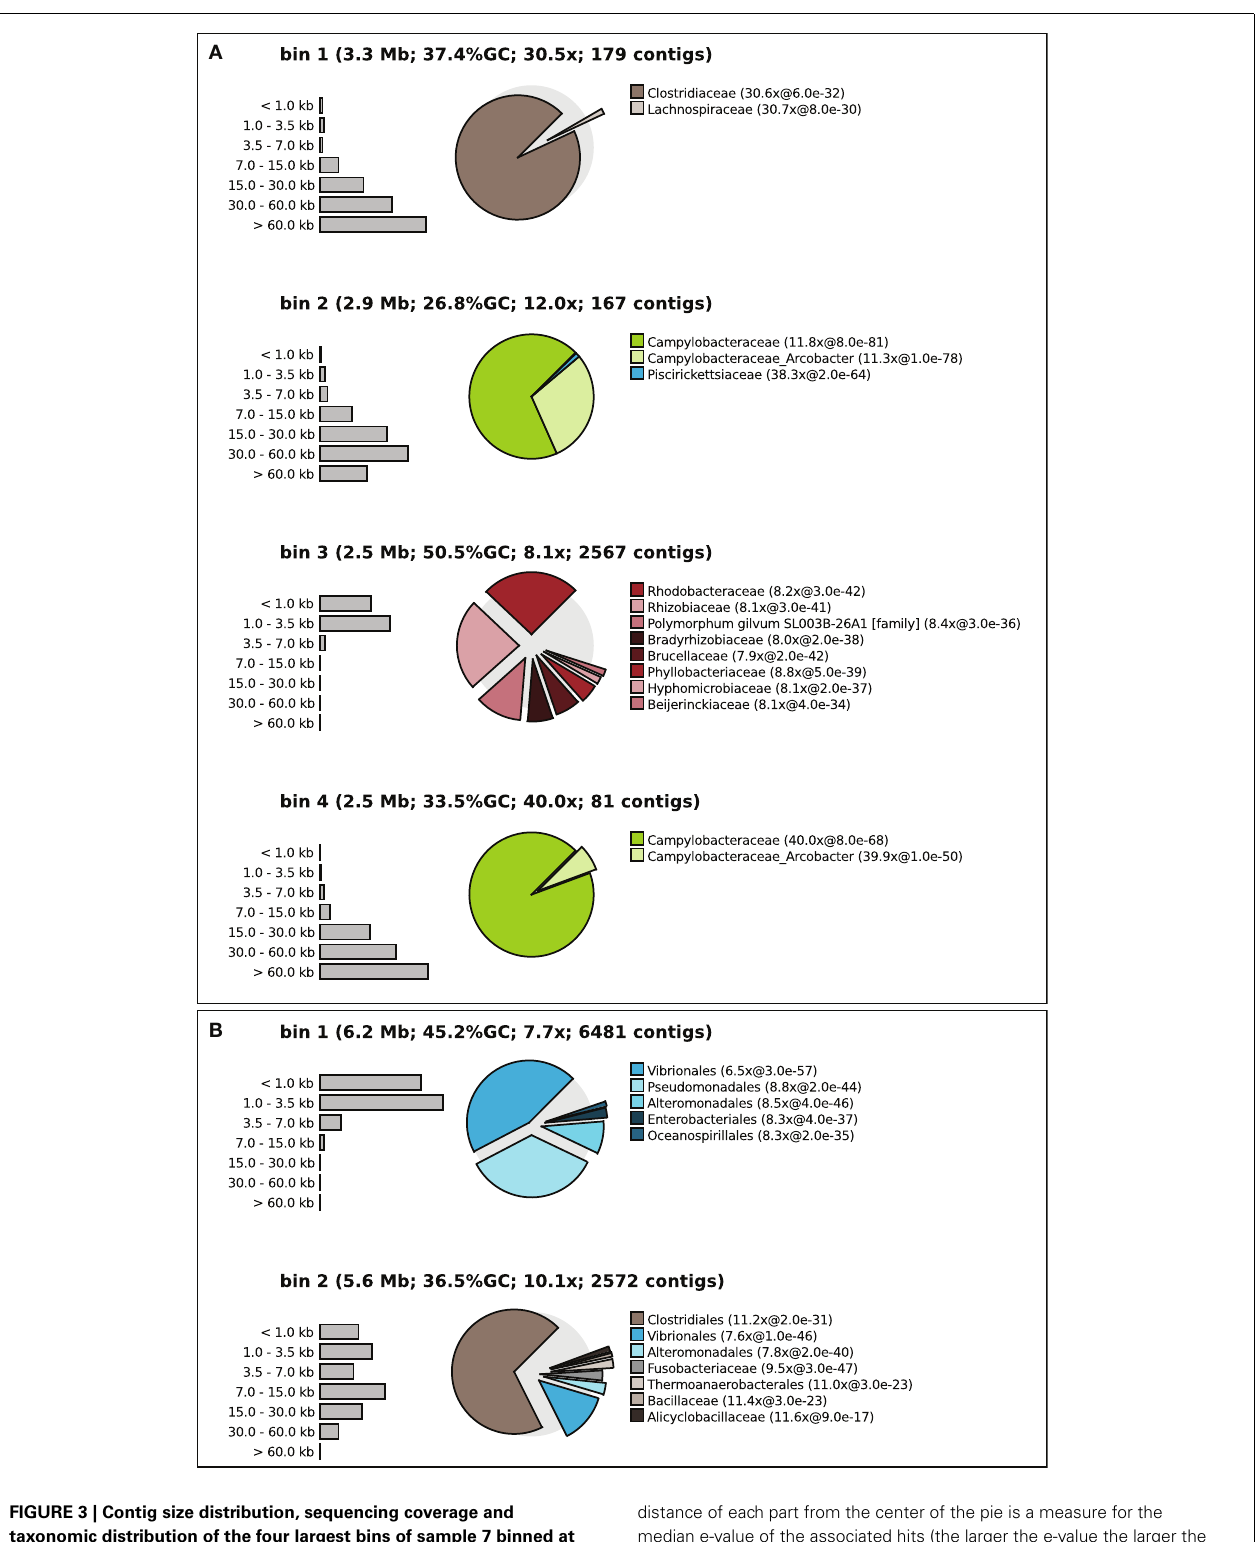
FIGURE 3 | Contig size distribution, sequencing coverage and taxonomic distribution of the four largest bins of sample 7 binned at medium confidence (A) and sample 1 binned at low confidence (B). The exploded pies show the taxonomic distribution of the bins.The